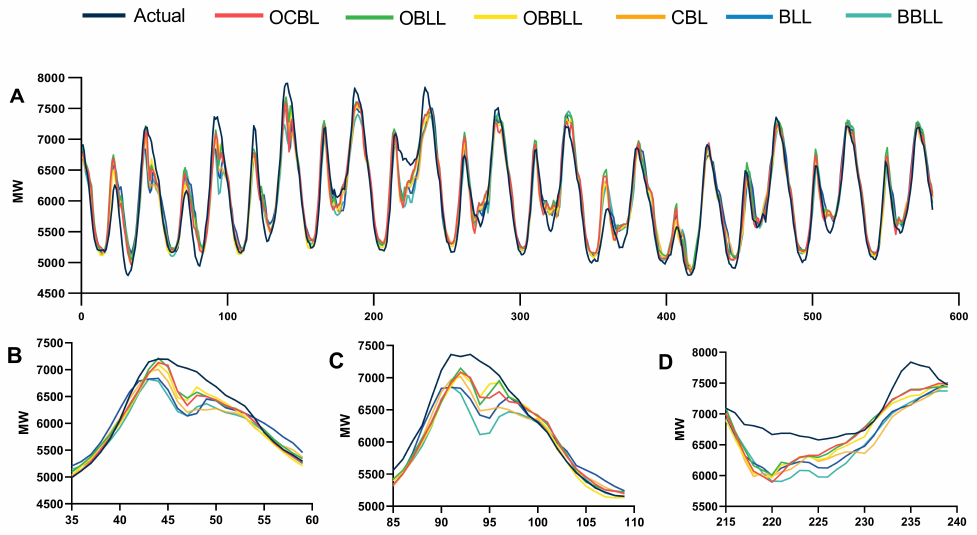
Figure 12. The prediction results and local observation for 3-step forecasting in 2019. ( A ) represents the whole prediction result. ( B – D ) describe the prediction result of different local observation interval.